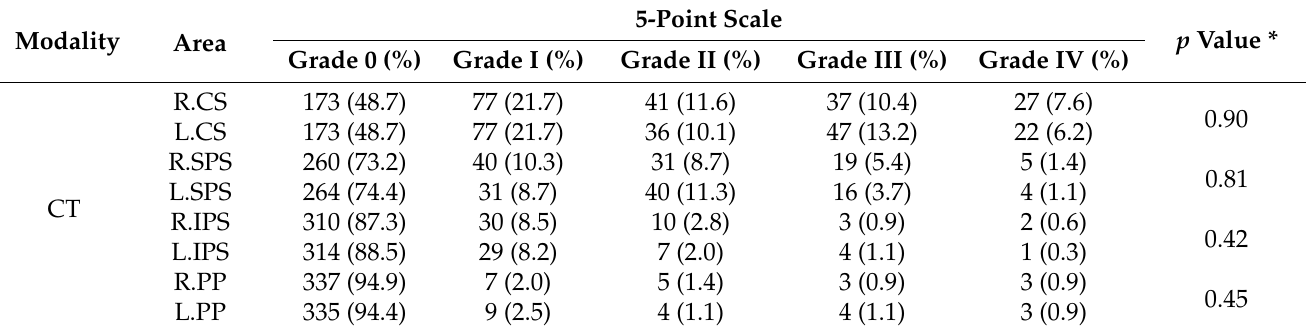
Table 2. Frequency of opacification in the CS, SPS, IPS, and PP by grading in 355 participants (cohort 1). Modality